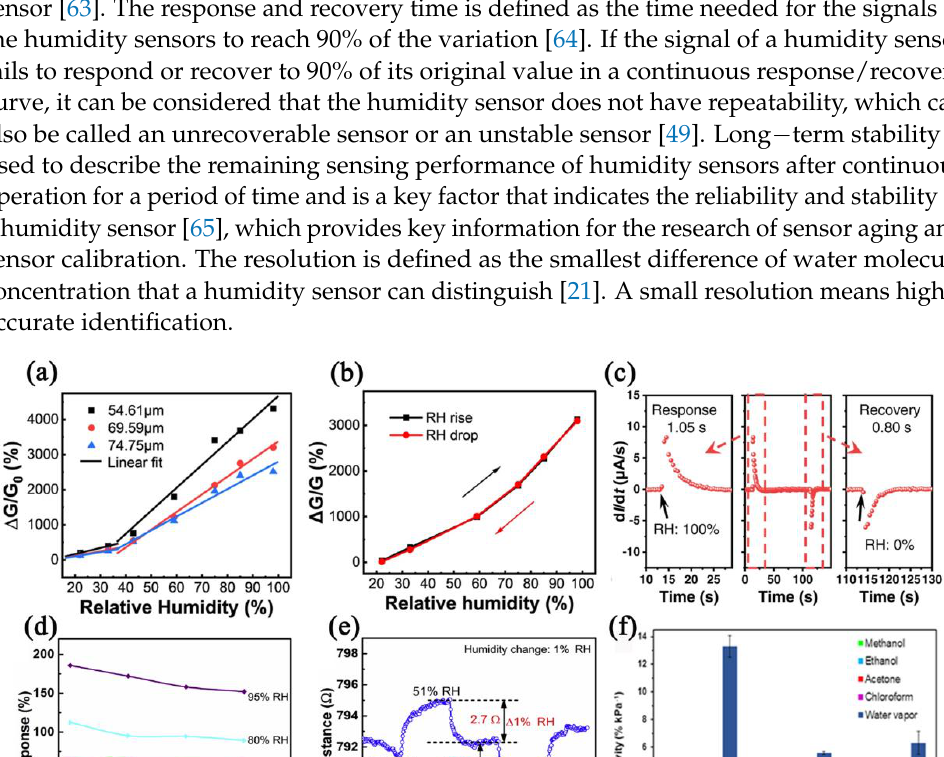
Table 1. Sensing properties of MOF − based impedance − type humidity sensors. Materials